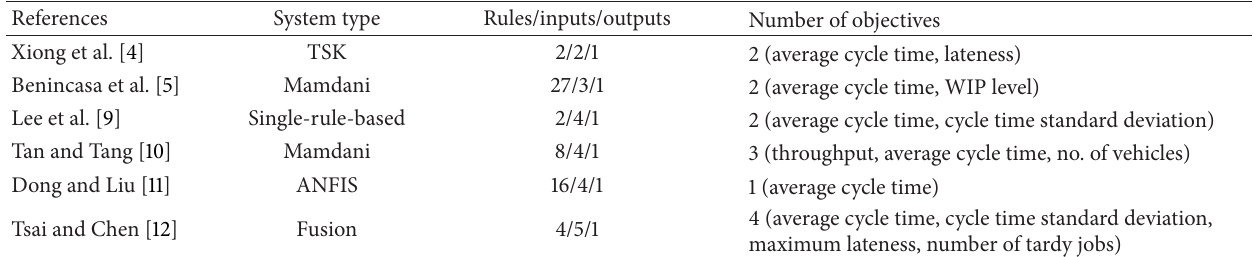
Table 1: Some existing fuzzy dispatching